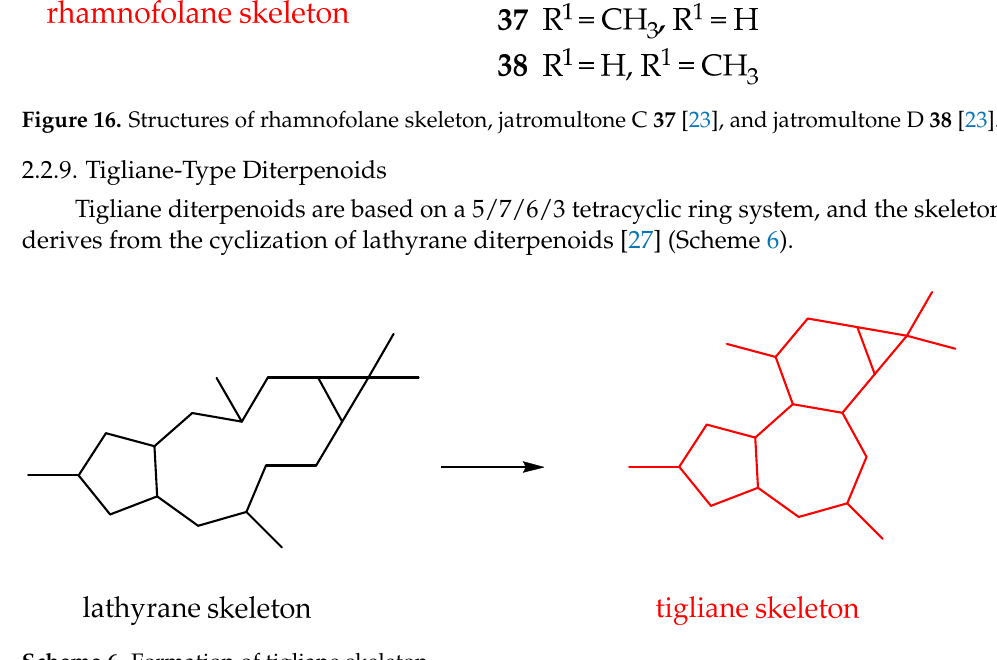
Scheme 6. Formation of tigliane